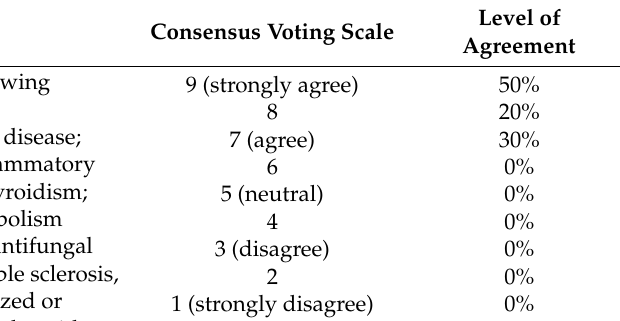
Table 4. Statement regarding screening of vitamin D deficiency in